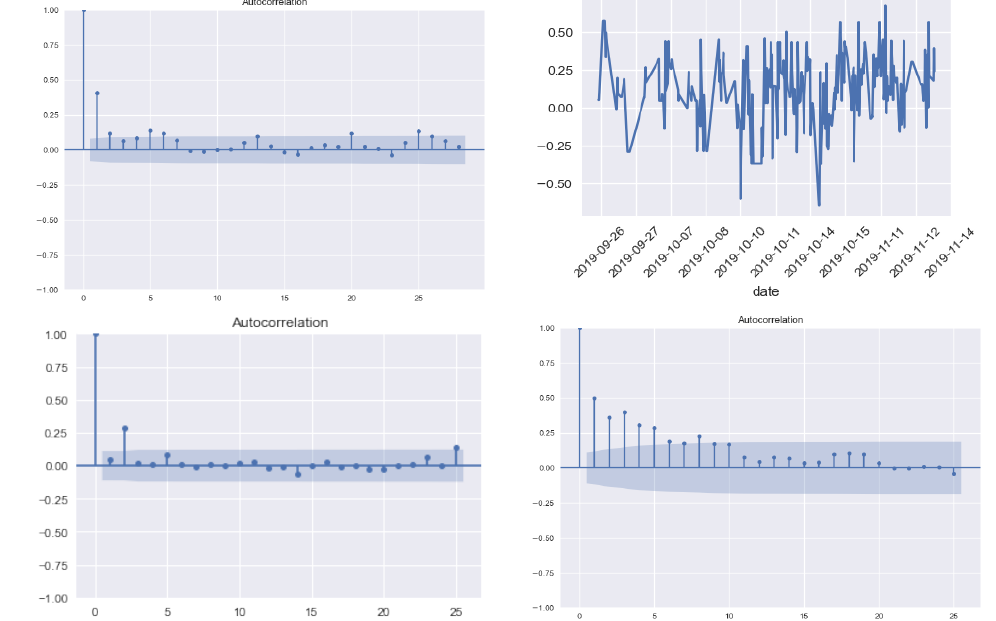
Figure 4. Popularity and Sentiment indexes of Jones ranging from 25 September 2019 to 18 February 2022 ( upper part ) and the corresponding autocorrelation function ( lower part